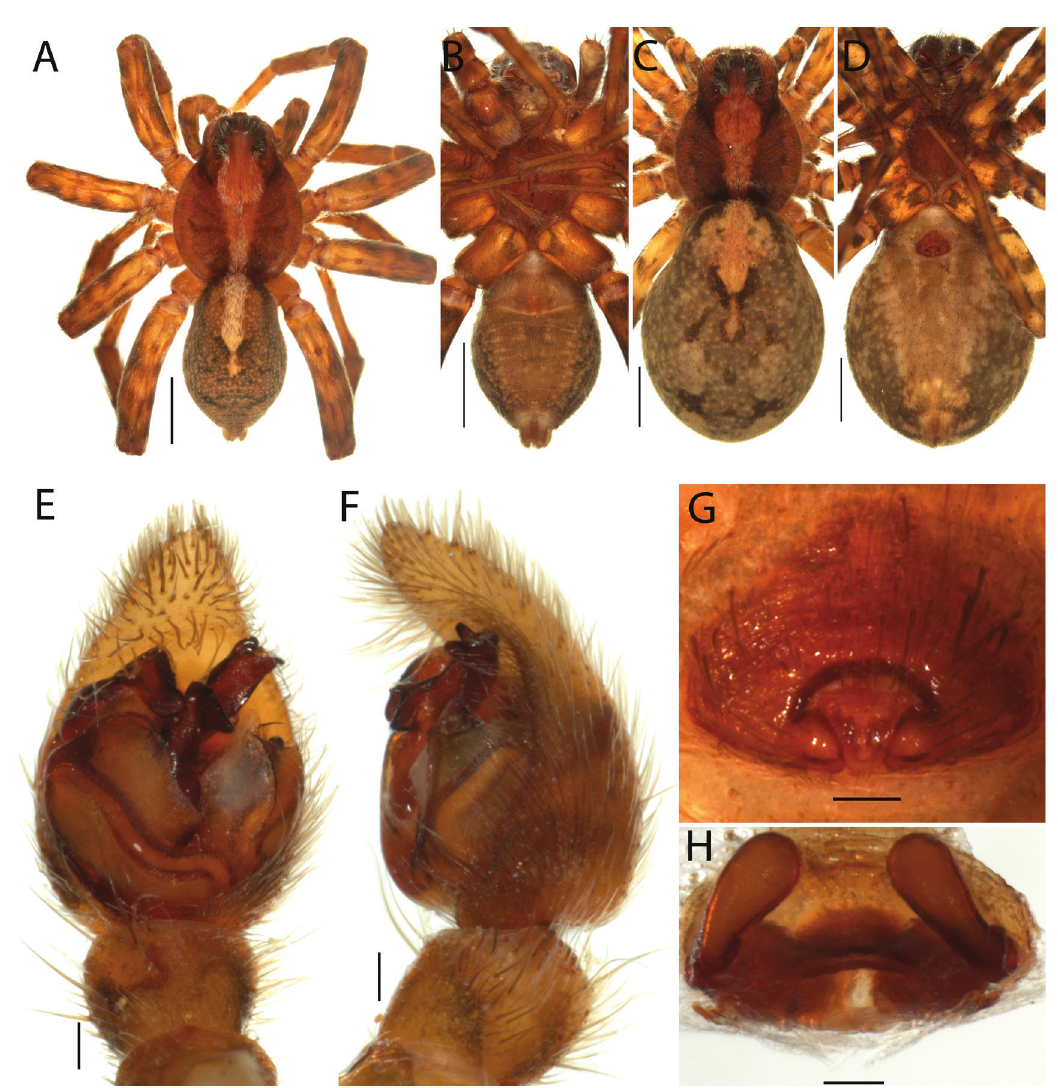
Figure 3. Artoria albopilata (Urquhart, 1893) male, female (AM KS116121): A , male habitus, dorsal view; B , male habitus, ventral view; C , female habitus, dorsal view; D , female habitus, ventral view; E, male pedipalp, ventral view; F , male pedipalp, retrolateral view; G , epigyne, ventral view; H , epigyne, dorsal view. Scale bars: habitus 1.0 mm; pedipalp, epigyne 0.1